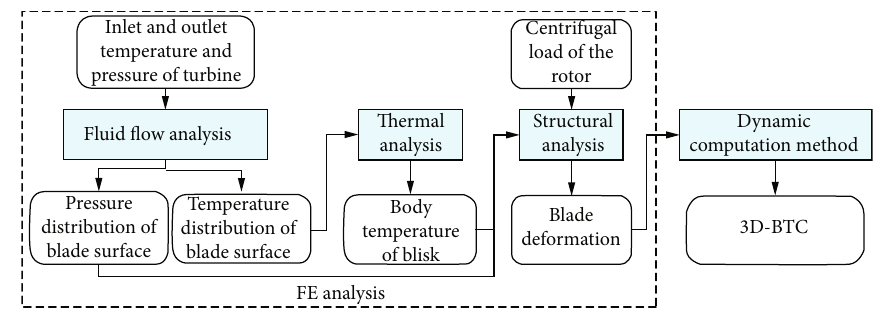
Figure 2: The fl owchart for analyzing the 3D-BTC of turbine